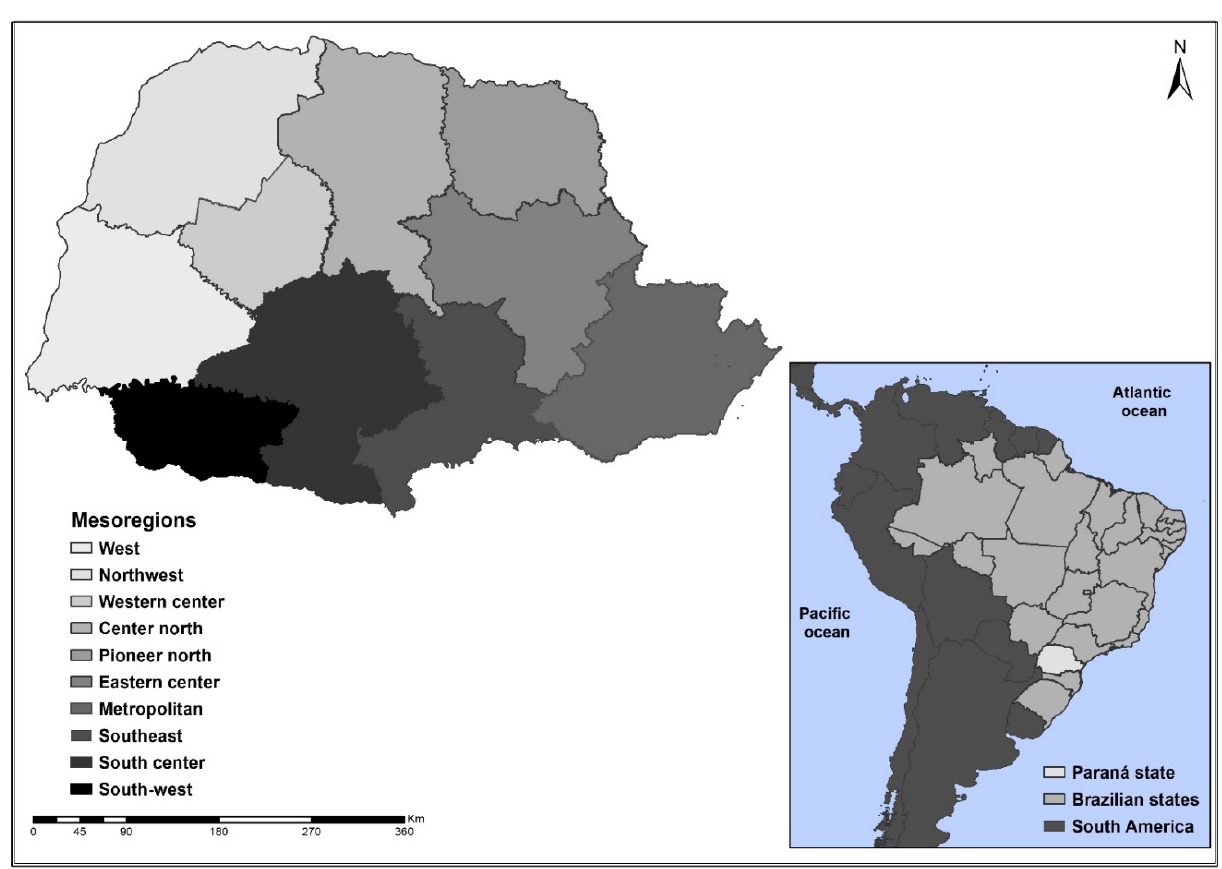
Figure 1. Geographic location of the state of Paraná and its mesoregions. Legend: ArcGIS [GIS software]. Version 10.0. Redlands, Califórnia, EUA: Environmental Systems Research Institute, Inc., 2010.